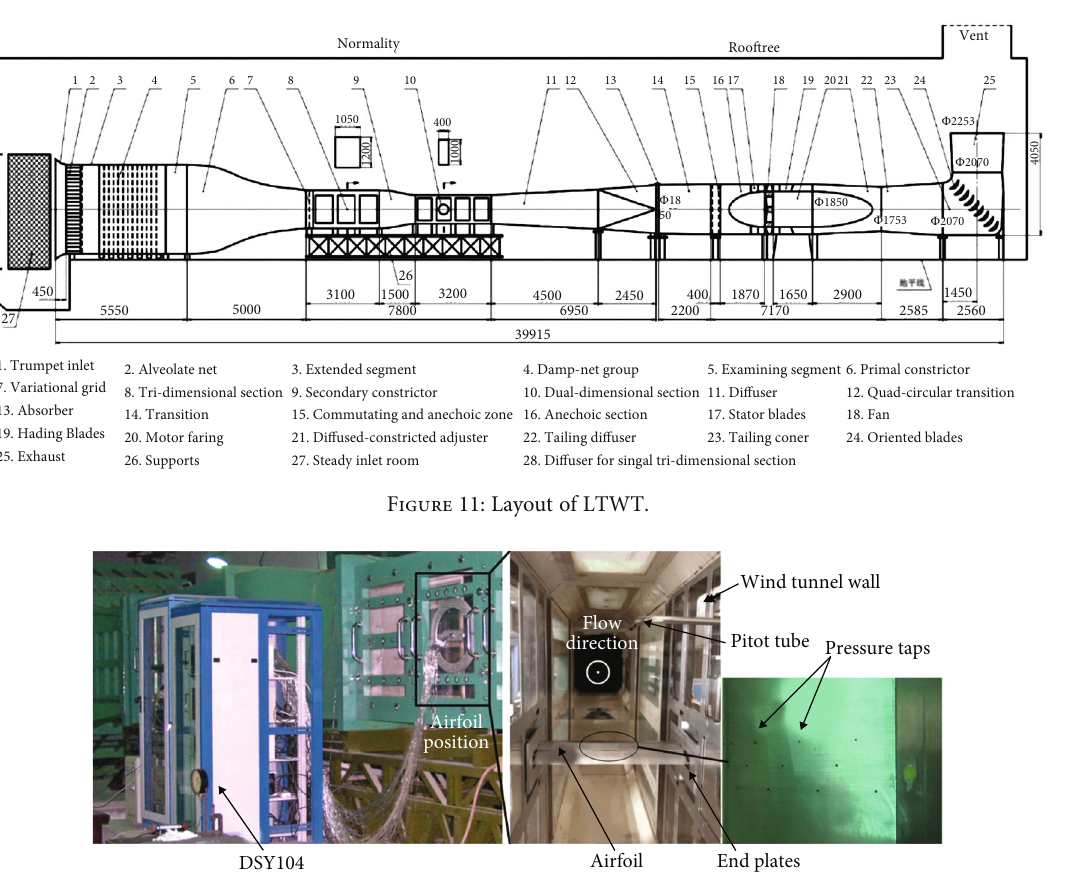
Figure 12: Hybrid airfoil installation in LTWT. Table 2: Test parameters for Cp.